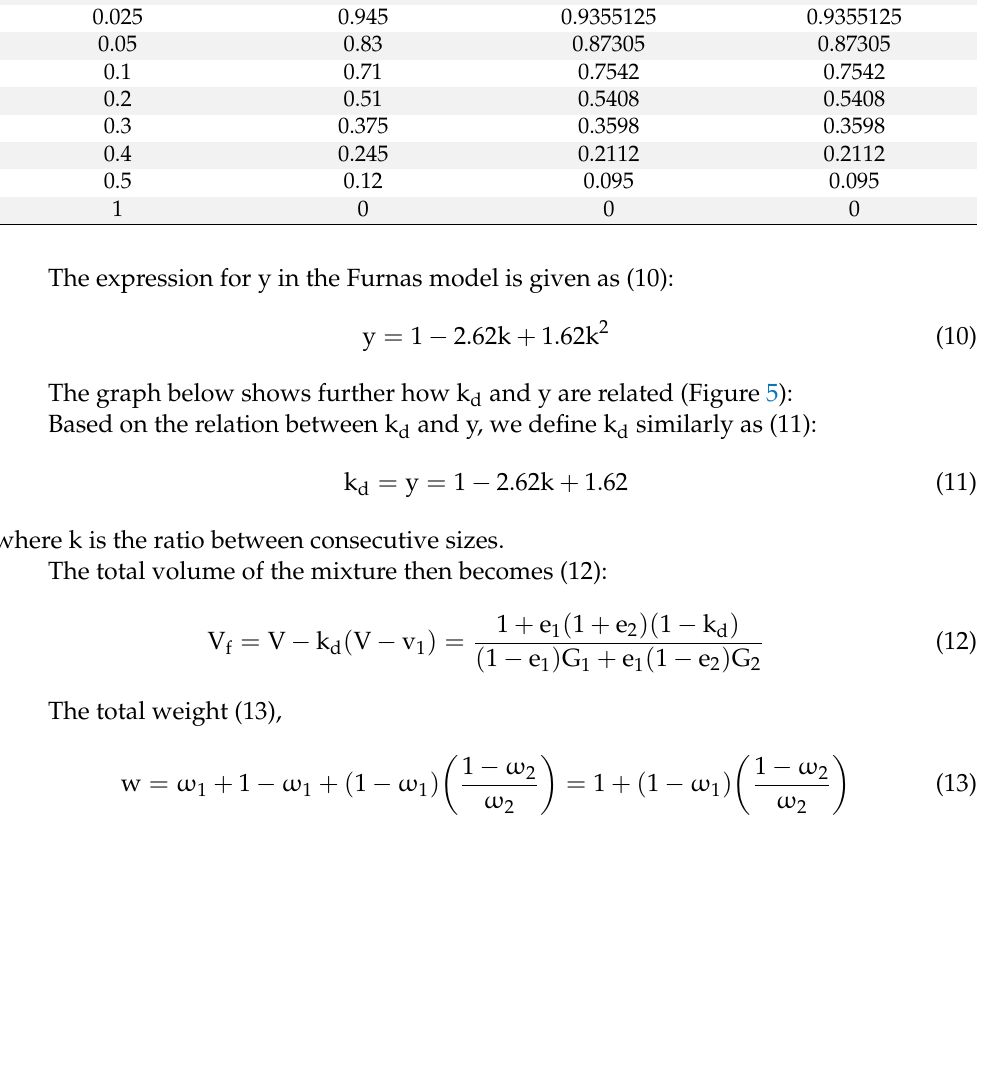
Table 1. Relationship between Reduction Factor and Contraction in Volume. K 1/n y